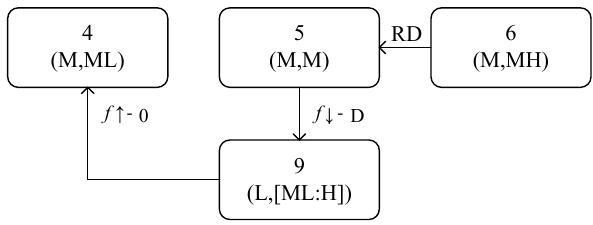
Figure 9. State transition of example case in Figure 8.